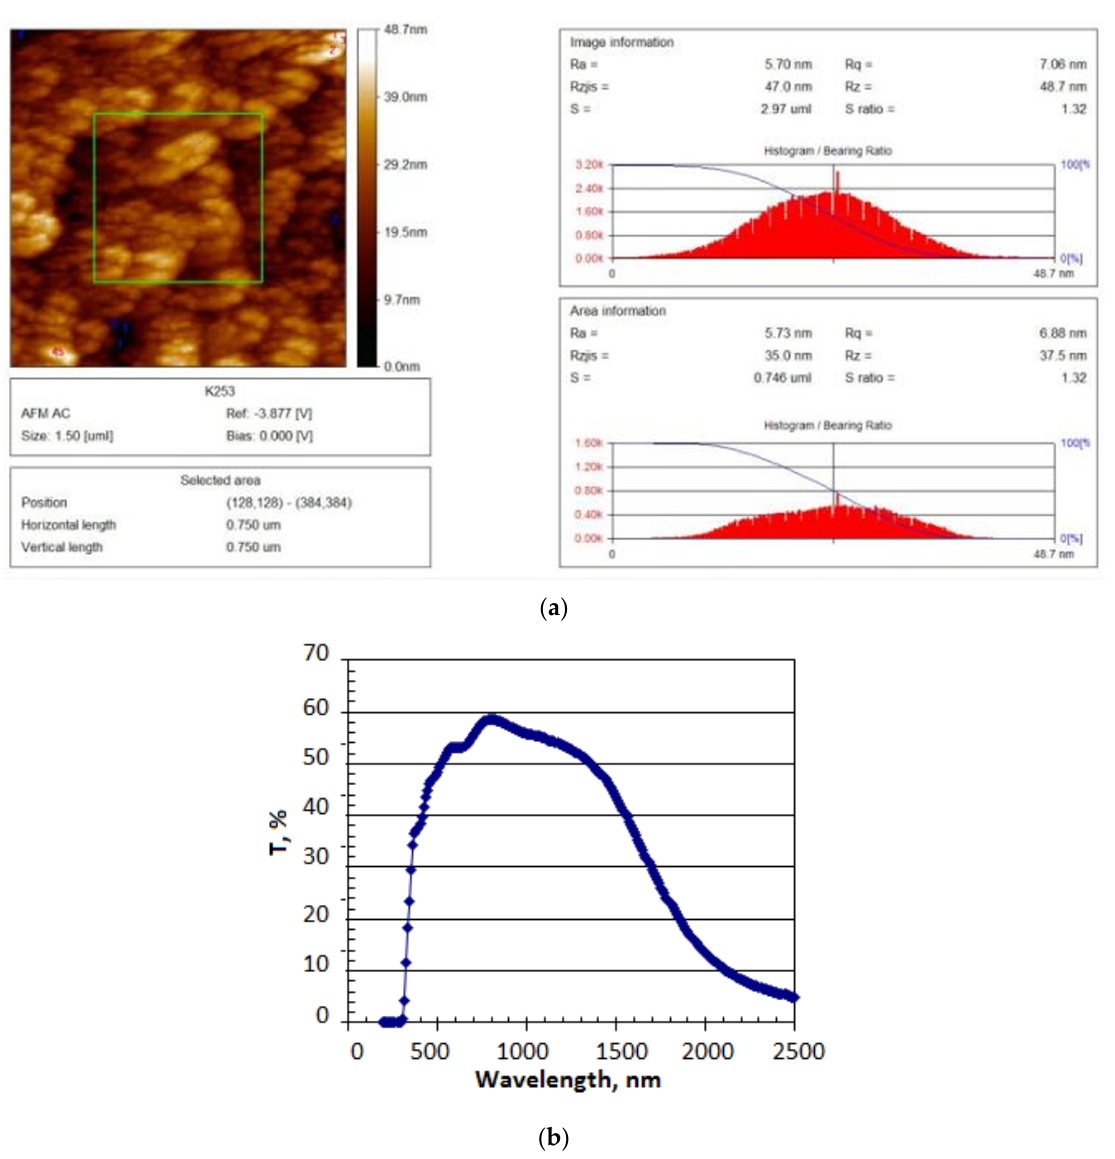
Figure 4. ( a ) AFM image of surface and distribution of particle sizes; ( b ) transmittance spectra of ZnS films.